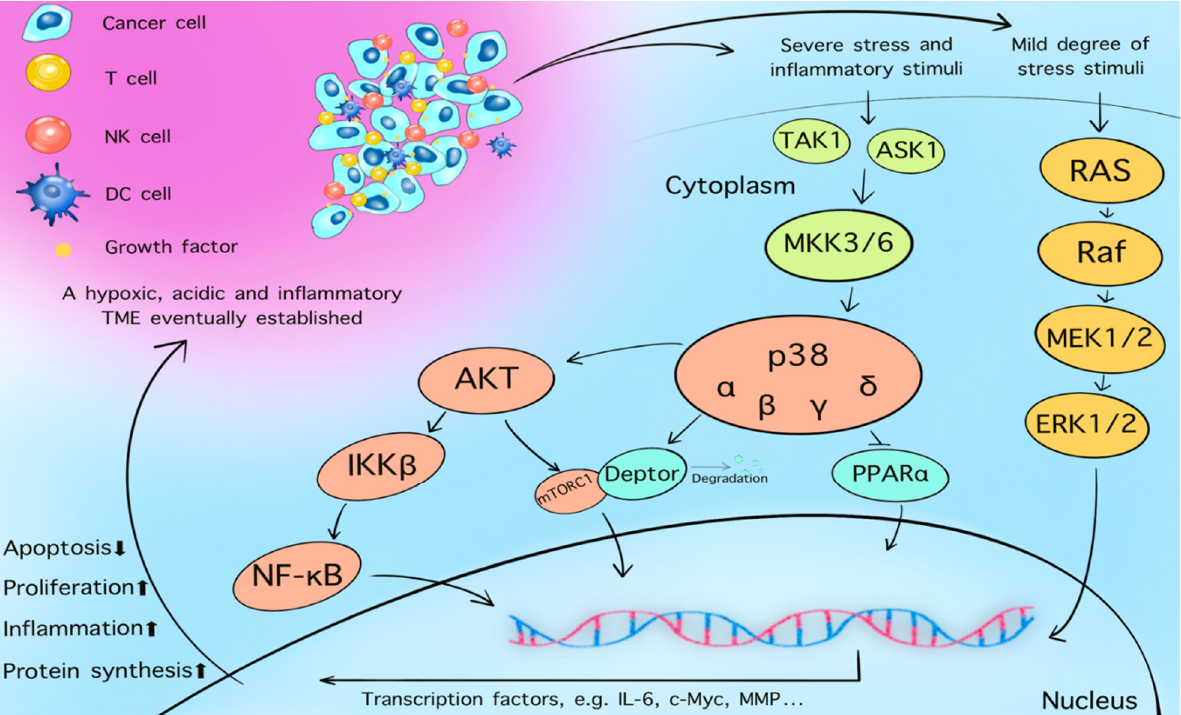
Figure 4. Four p38 subfamilies have been identified: p38- α , - β , - γ , and - δ [96]. MAPK cascade is the main mechanism by which the four p38 isoforms are activated in human cells [97]. Protein kinase activity of p38 is stimulated by oncogenic TAK1 or ASK1 through its downstream mitogen-activated protein kinase kinases, MKK3 and MKK6, under conditions of severe stress and inflammation (under mild stress, the ERK/MAPK pathway is activated) [98]. Activated p38 also interacts with AKT and NF- κ B, triggering downstream mTORC1 via the degradation of DEPTOR, or by suppressing the activation of PPAR α [95]. These changes promote cell proliferation, inflammation, protein synthesis, and decrease apoptosis, ultimately leading to a hypoxic, acidic, and inflammatory TME.